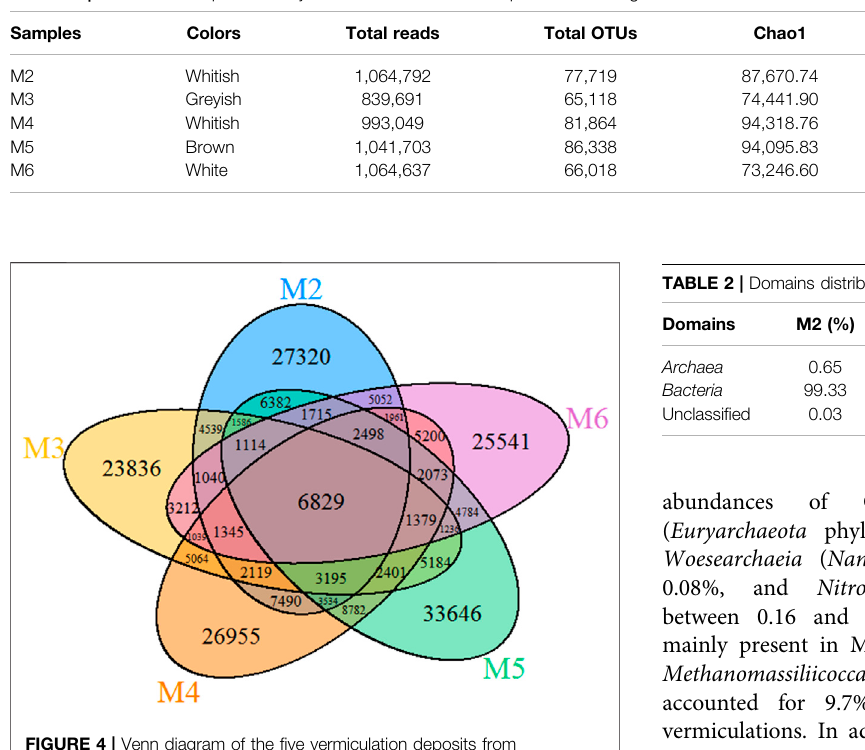
FIGURE 4 | Venn diagram of the fi ve vermiculation deposits from Morgana Cave.